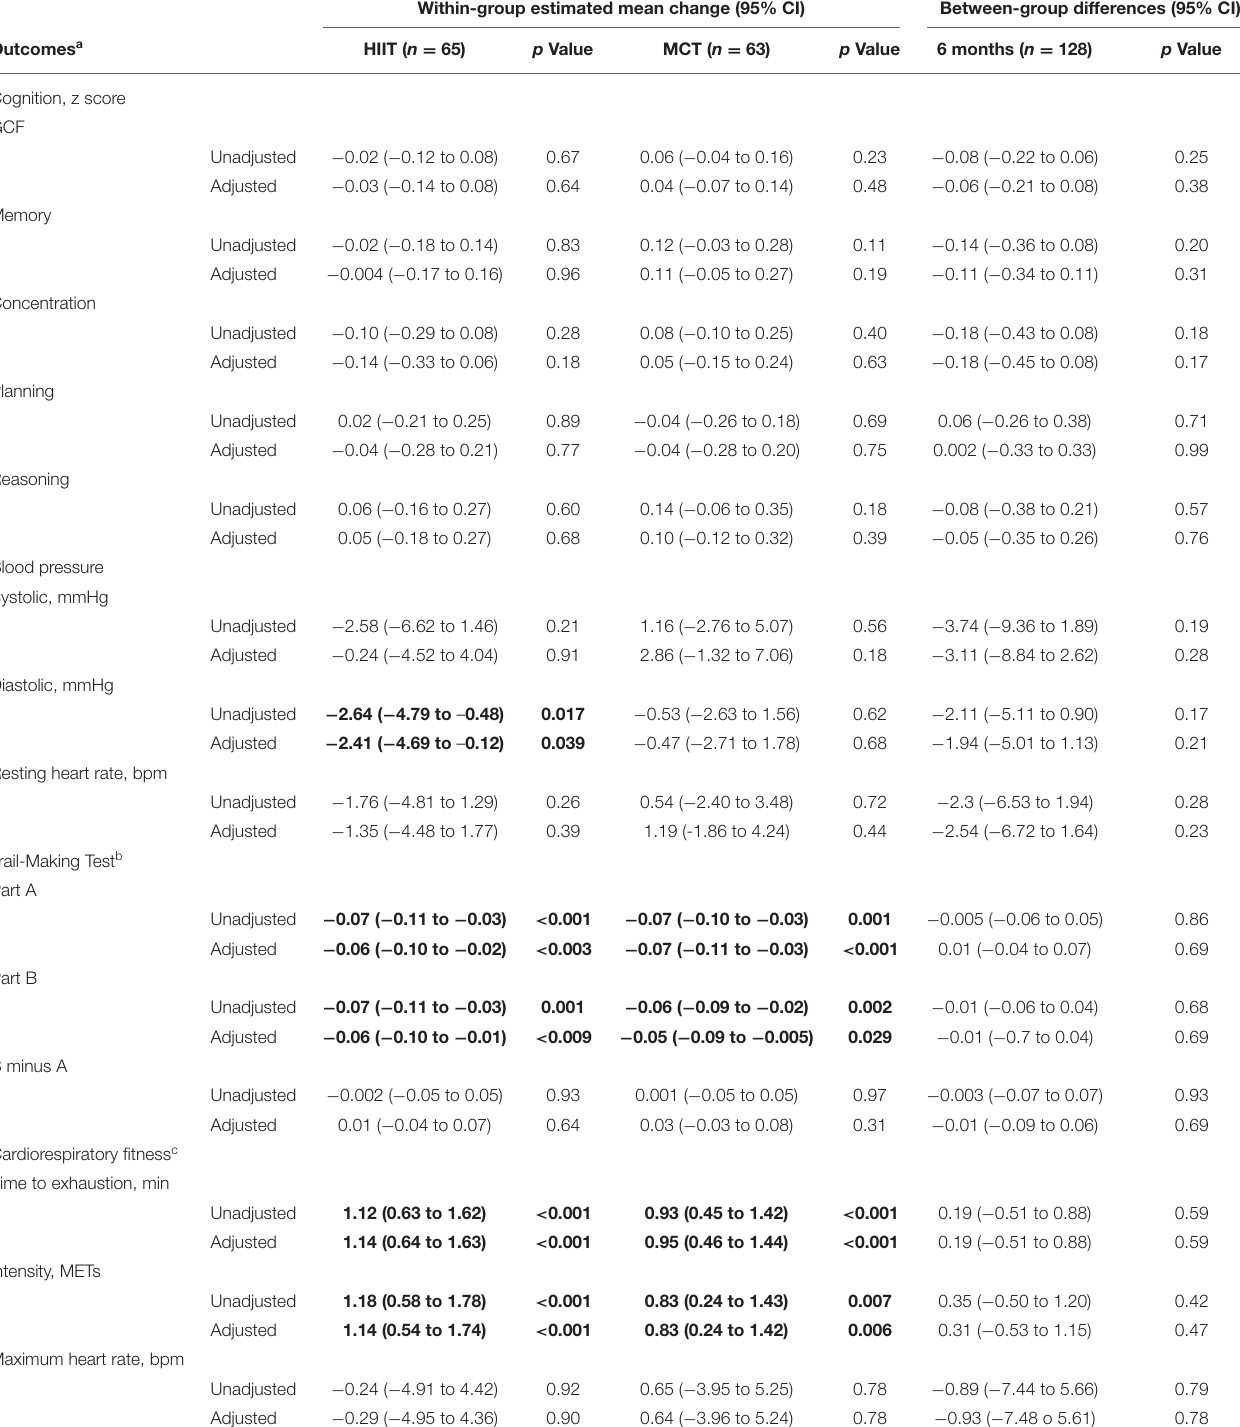
TABLE 3 | Within- and between-group differences from baseline to 6 months by randomization group. Within-group estimated mean change (95% CI) Between-group differences (95%